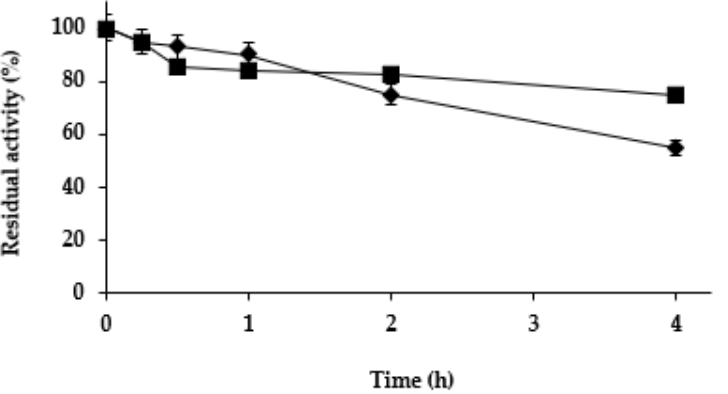
Figure 5. Thermal inactivation courses of agarose C8-TLL-ZnP (rhombus) and Purolite C18-TLL-ZnP (squares). Other specifications are described in Methods.